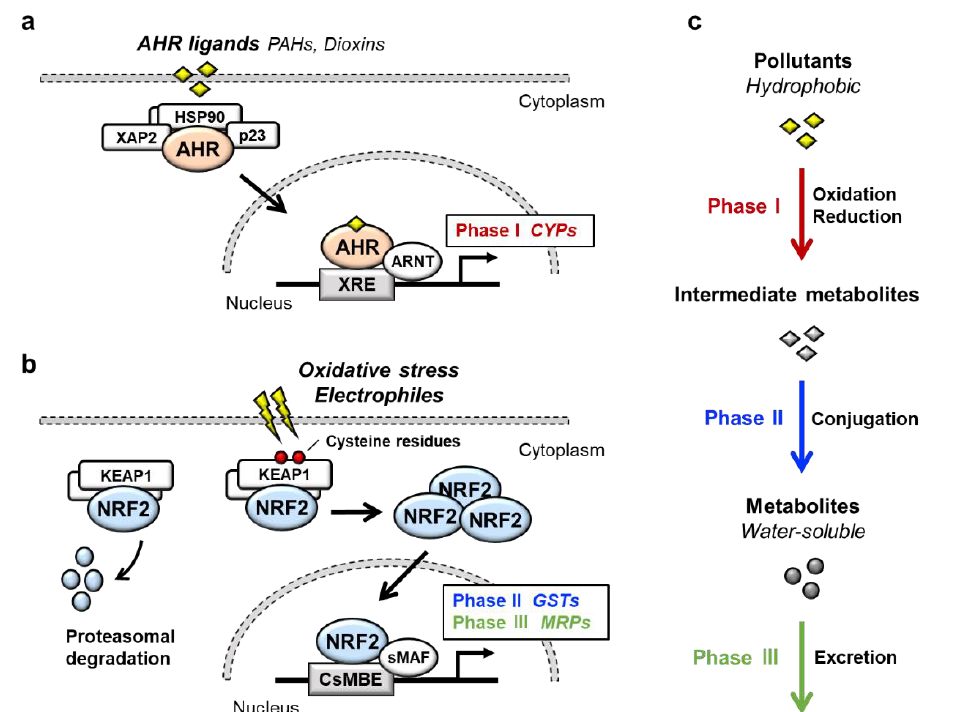
Figure 1. AHR and NRF2 in xenobiotic detoxification. ( a ) The AHR signaling pathway. In the absence of a ligand, AHR forms a complex with HSP90, p23 and XAP2 in the cytoplasm. Upon binding of ligands such as PAHs or dioxins, AHR translocates into the nucleus and forms a heterodimer with ARNT. The AHR-ARNT heterodimer binds to XRE in regulatory regions of target genes, which mainly encode phase I detoxification enzymes. ( b ) The KEAP1-NRF2 system. Under physiological conditions, KEAP1 binds and ubiquitinates NRF2 in the cytoplasm and promotes the degradation of NRF2 through the ubiquitin–proteasome pathway. Upon exposure to oxidative or electrophilic stresses, reactive cysteine residues of KEAP1 are modified, which leads to dysfunction of the ubiquitin ligase activity of KEAP1. Under this condition, newly made NRF2 escapes from KEAP1, translocates into the nucleus and forms a heterodimer with sMAF. The NRF2-sMAF heterodimer binds to CsMBE (also known as ARE or EpRE) in the regulatory regions of target genes, which mainly encode phase II detoxication enzymes and phase III transporters. ( c ) Xenobiotic detoxification. Xenobiotic detoxification consists of three phases. The phase I detoxication reaction involves oxidation or reduction of hydrophobic xenobiotics. The phase II detoxification reaction involves conjugation of the hydrophilic moiety by transferases to phase I metabolites, leading to the transformation of hydrophobic xenobiotics into water-soluble molecules. In the phase III reaction, the conjugated metabolites are eliminated from the cells through MRPs.